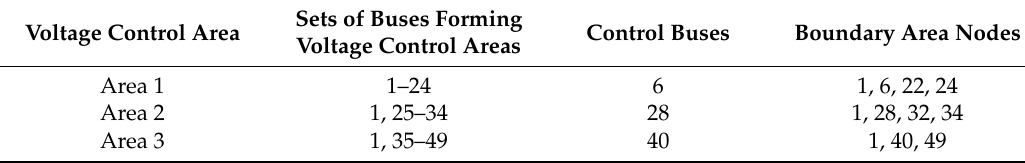
Table 1. Voltage control areas and their associated control